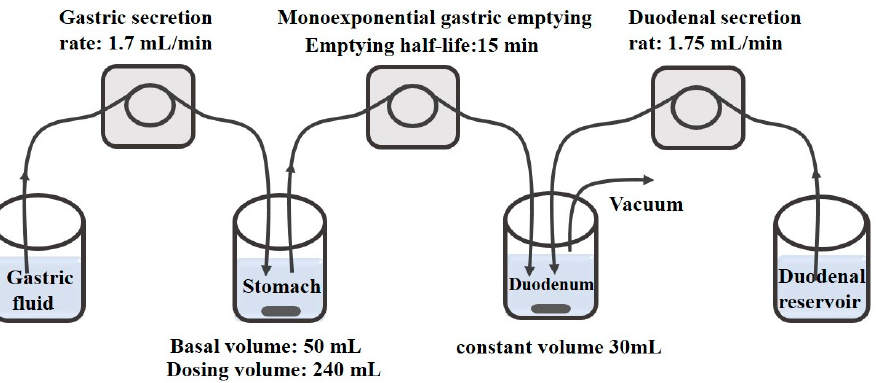
Figure 5. Schematic diagram of the simulated stomach duodenum model. Reprinted with permission from Ref. [6]. 2023, American Chemical Society.